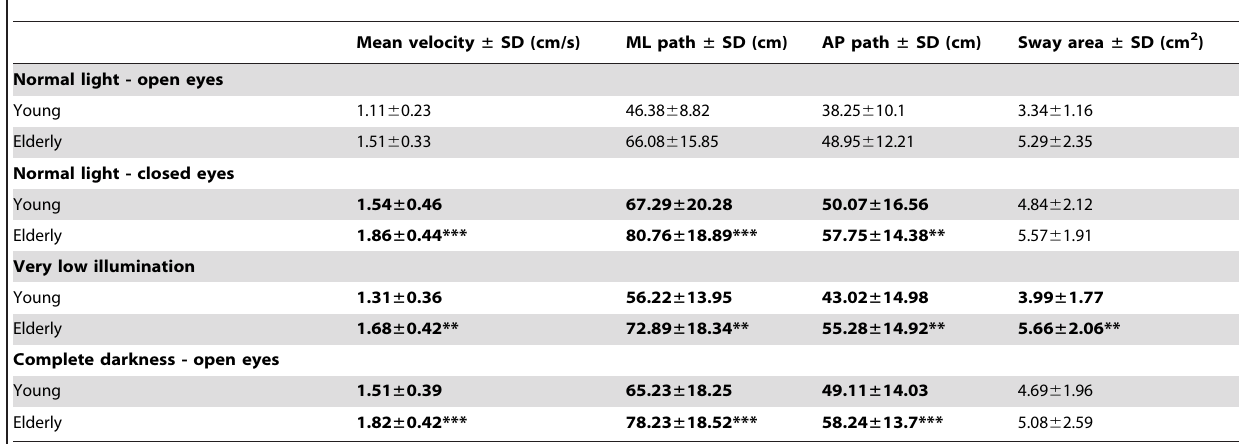
Table 2. Mean values for the time domain postural sway variables in the different illumination conditions for the groups of 18 young and 26 elderly participants (the bold figures indicate significant differences compared to the initial normal light eyes open